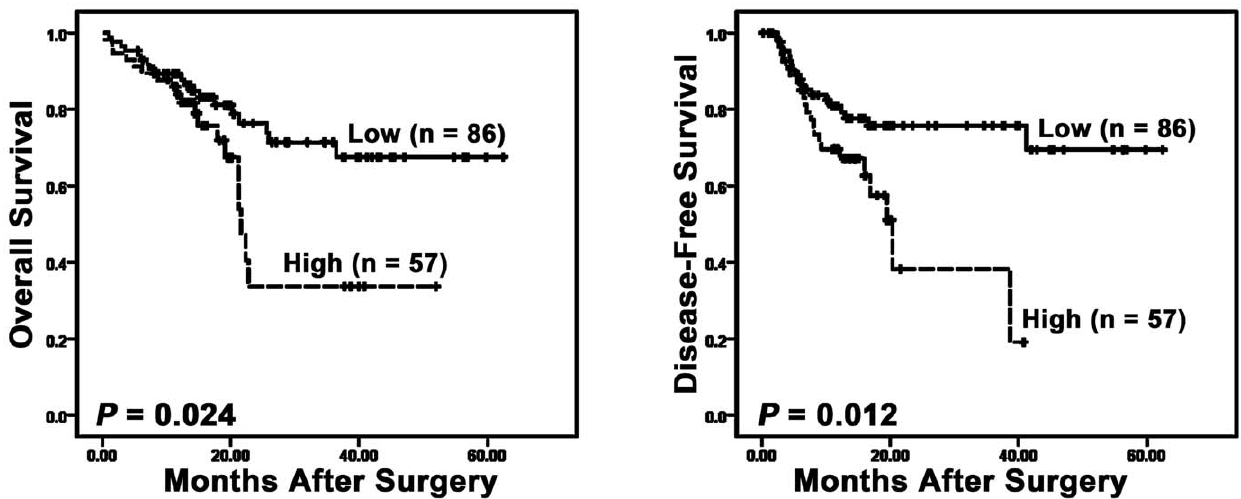
Figure 6. Accumulation of tumor Treg cells predicts poor survival in patients with hepatocellular carcinoma. The cumulative overall survival and disease-free survival of HCC patients were estimated using the Kaplan-Meier method and compared by the log-rank test. Patients with high FoxP3 + Tregs (dashed lines) had significantly poorer survival compared with individuals with low FoxP3 + Treg density (solid lines). doi:10.1371/journal.pone.0024671.g006 PLoS ONE |